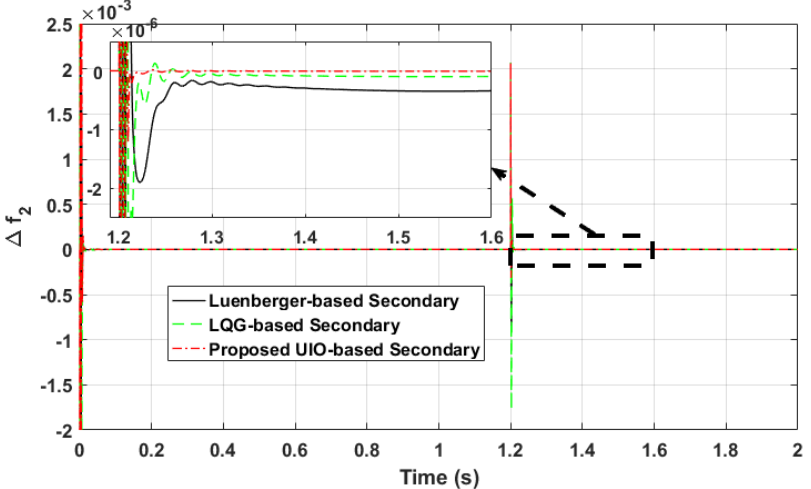
Figure 12. Second inverter frequency dynamic ∆ f 2 in scenario 2 (FDI into second inverter’s